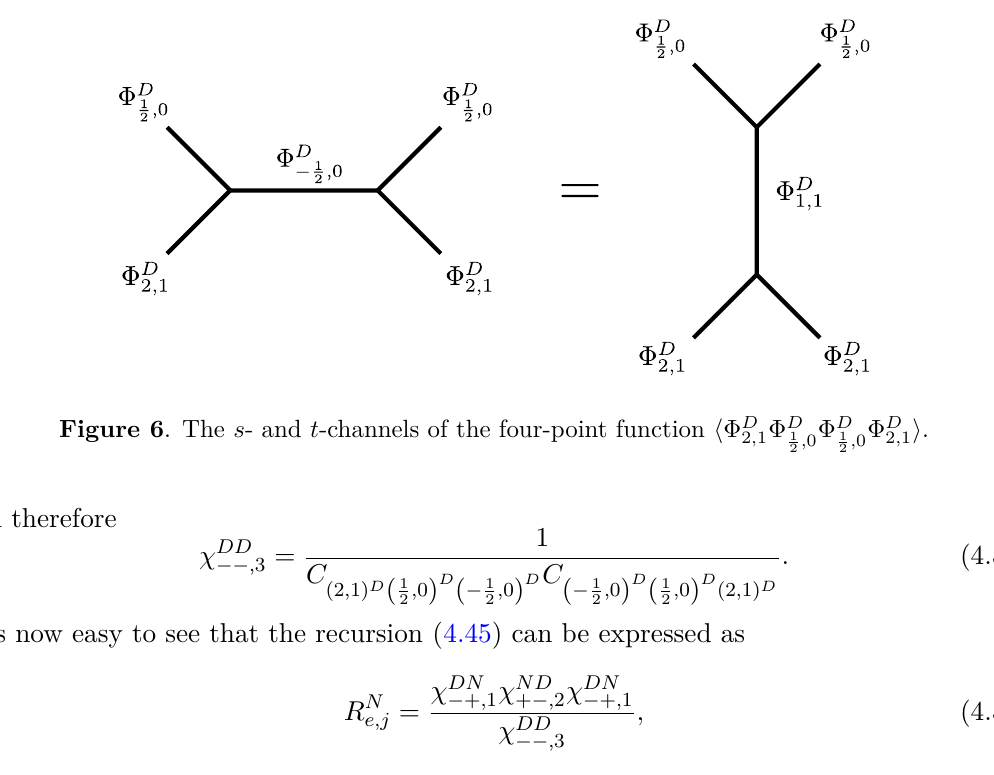
Figure 5 . The s - and t -channels of the four-point function h Φ D ance of the identity field Φ D normalization of the two-point functions.